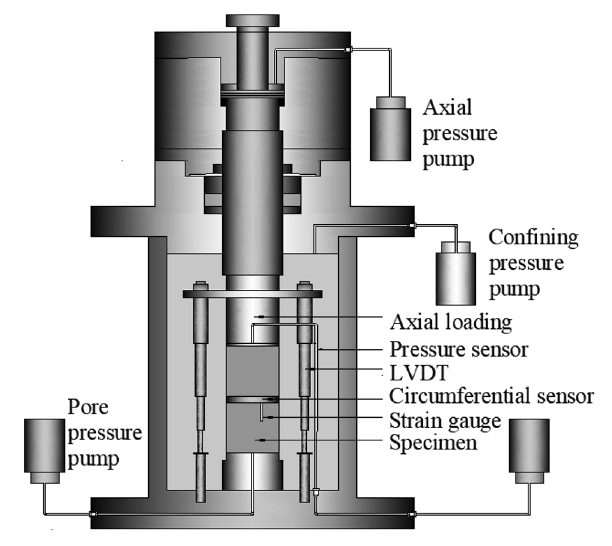
Fig. 2 Schema of rock servo-controlled triaxial equipment